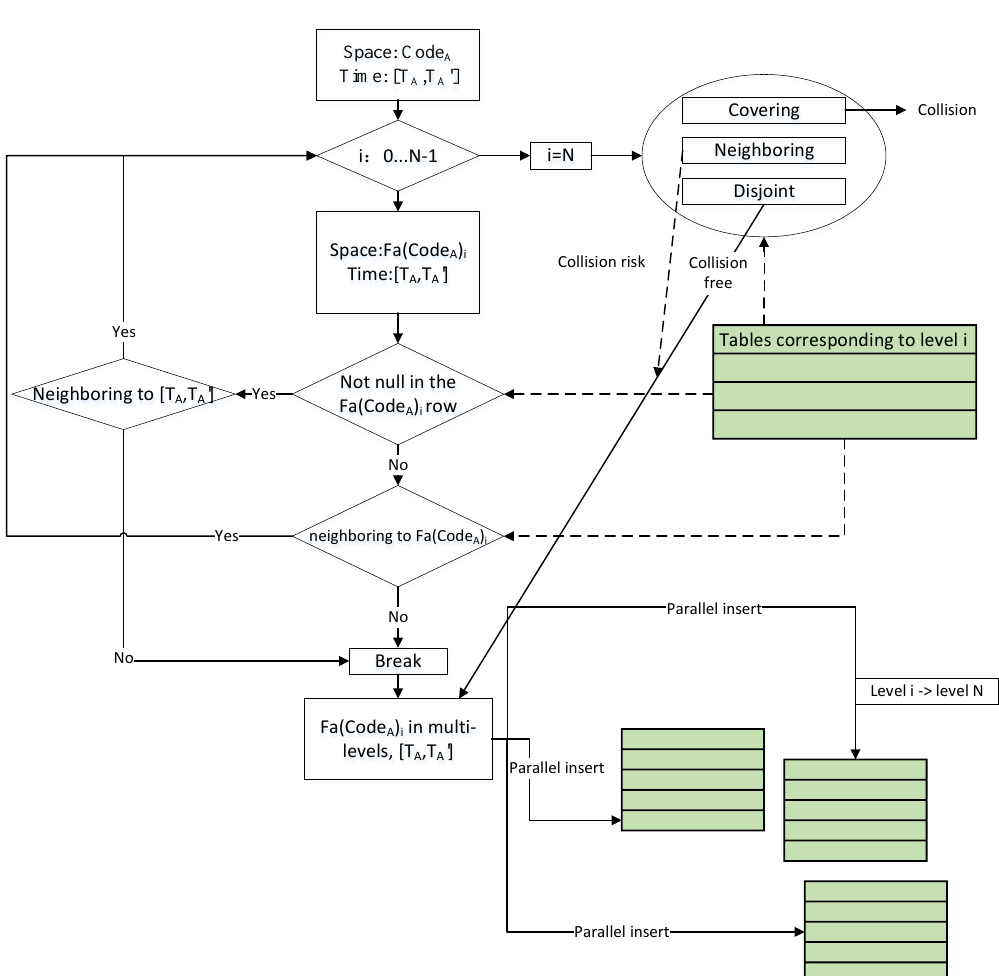
Figure 4. Collision detection for a single grid. A single spatiotemporal grid with Code A and a time interval from T A to T A ’ is compared with the existing data at multiple levels. After determining the spatial relationship, the spatiotemporal grid information can be inserted into multiple data tables in parallel.